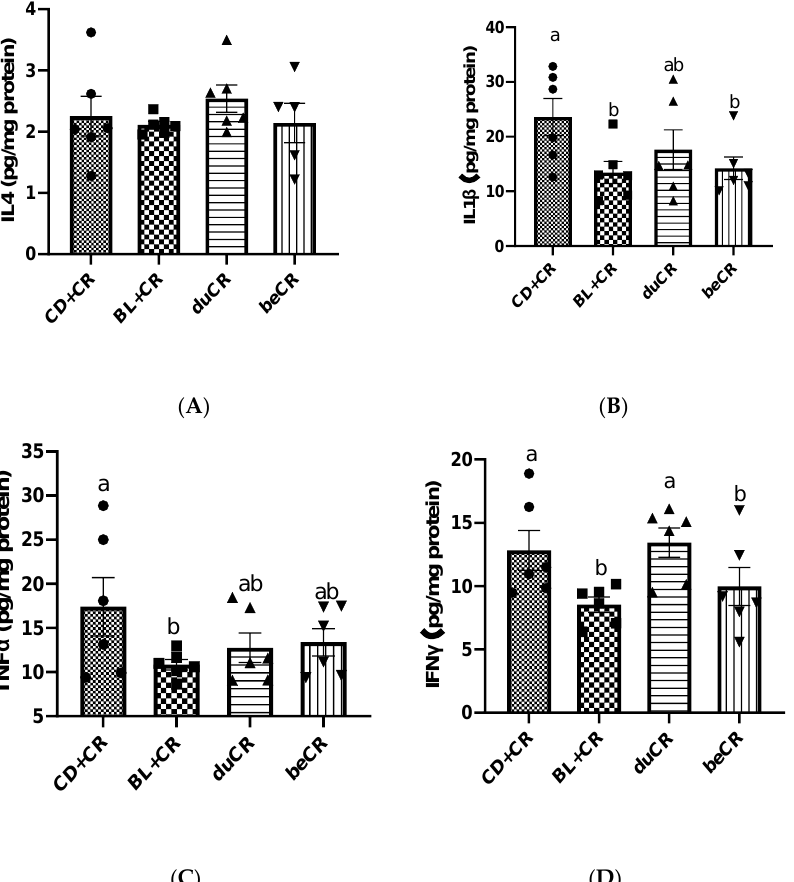
Figure 3. Effect of the beCR and duCR intervention on inflammatory cytokines in colon. The concentrations of anti-inflammatory cytokines (IL-4) ( A ) and pro-inflammatory cytokines IL-1 β ( B ), TNF- α ( C ), and IFN γ ( D ) in colonic tissue of mice. The a, b means in the same bar without a common letter differ at p < 0.05.